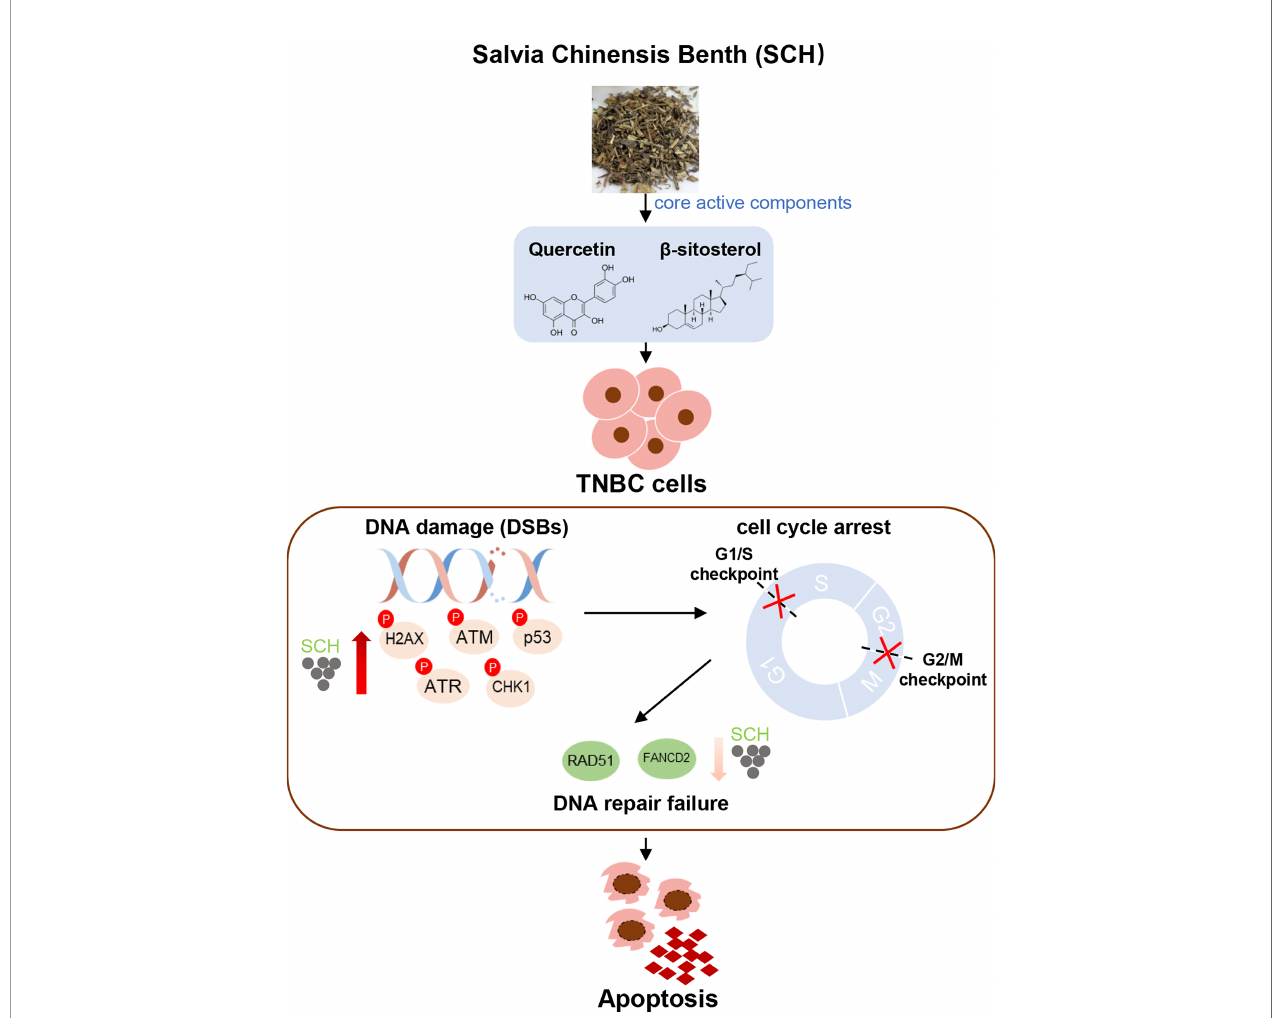
FIGURE 9 | Schematics illustrate the identi fi ed signaling cascade triggered by SCH treatment. In TNBC cells, SCH treatment causes DNA damage (increased phosphorylation levels of H2AX, ATM, p53, ATR, and CHK1), which leads to cell-cycle arrest. At the same time, SCH treatment suppresses DNA repair (reduced RAD51 and FANCD2), and DNA repair failure fi nally leads to